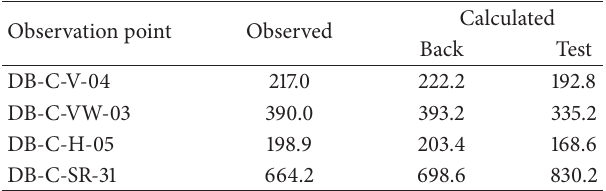
Table 5: Comparison of displacement values